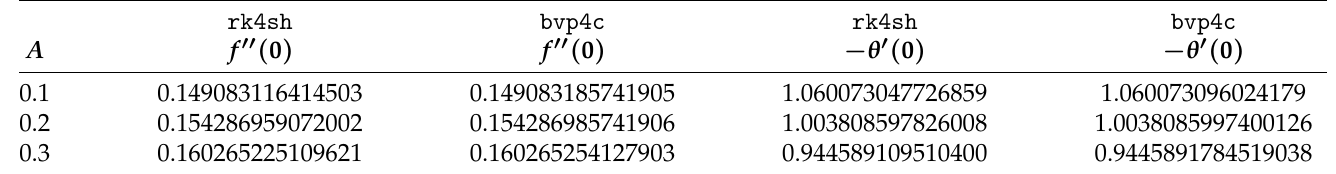
Table 3. Reliance on numerical integration for moving wedge λ = 1 and η ∞ = 5.